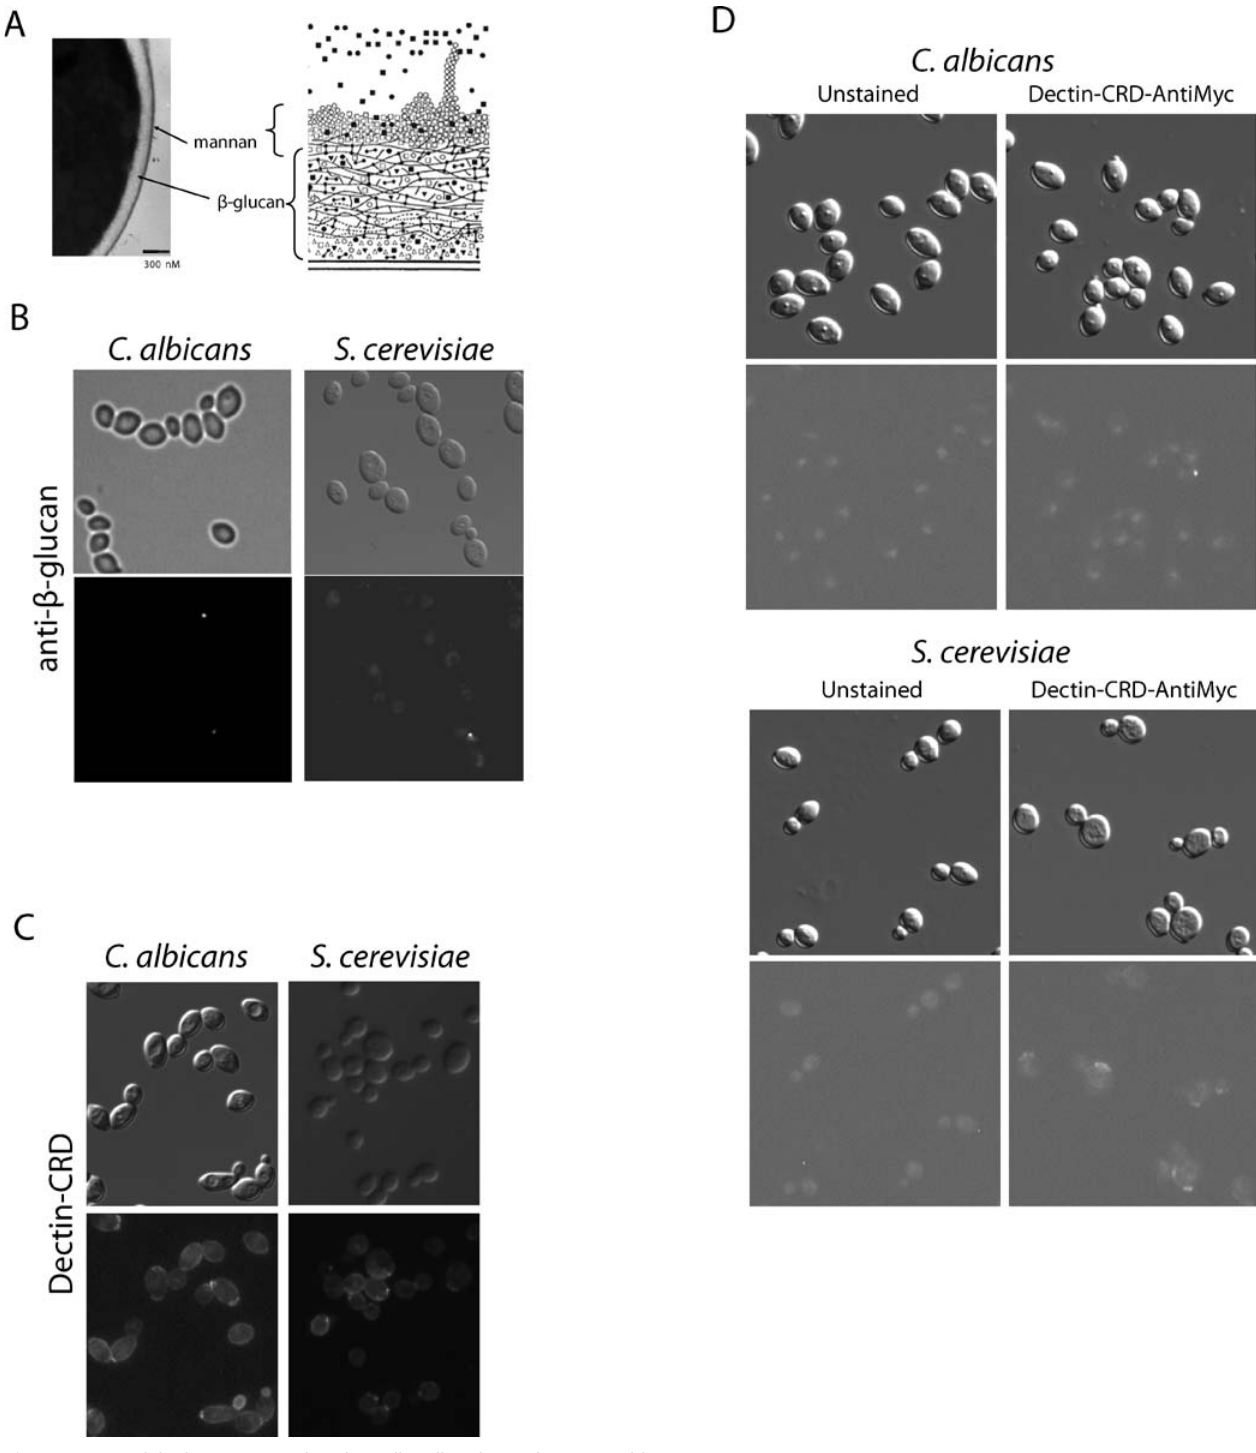
Figure 1. Fungal b -Glucan Is Buried in the Cell Wall and Largely Inaccessible (A) Transmission electron micrograph demonstrating layer structure of fungal cell wall (courtesy of C. Rondeau). The plasma membrane is tightly connected to a thick layer of b -glucan network. Mannoproteins are linked to b -glucan and protrude outside of this layer to make up a dense coat. Schematic adapted from [5]. (B–D) There is little b -glucan on live C. albicans or S. cerevisiae that is exposed and accessible to the anti- b -glucan antibody (B), the Dectin-CRD (C), or the Dectin-CRD-anti-Myc probe (D). The staining with anti- b -glucan and Dectin-CRD-anti-Myc is nearly indistinguishable, and is more specific than that with the directly labeled Dectin-CRD. The Dectin-CRD-anti-Myc has the same size as an antibody and the same specificity as Dectin-1. The difference in staining between the b -glucan-binding reagents (B and D versus C) is likely due to the size of the reagents (IgG has dimensions of approximately 95 A˚ 3 171 A˚ [33], while the CRD of CD69, which is similar to the Dectin-1 CRD, has dimensions of 44 A˚ 3 32 A˚ 3 30 A˚ [34]) relative to the estimated pore size of the S. cerevisiae cell wall (58 A˚ [23]), and thus the monomeric Dectin-CRD likely has more access to smaller areas of exposed b -glucan. DOI: 10.1371/journal.ppat.0020035.g001 PLoS Pathogens |